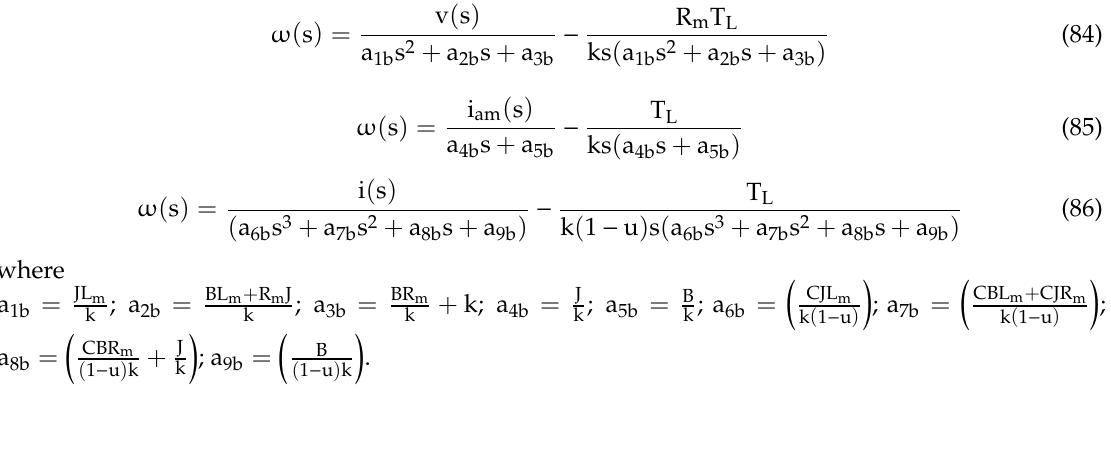
Figure 8. Integral Square Error (ISE) for ETEDPOF and proportional-integral controller (PIC).